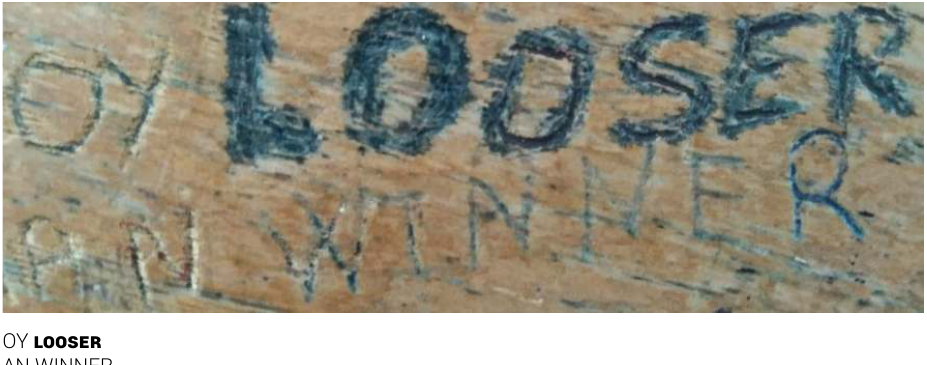
OY LOOSER AN WINNER Photo: J. Peake.